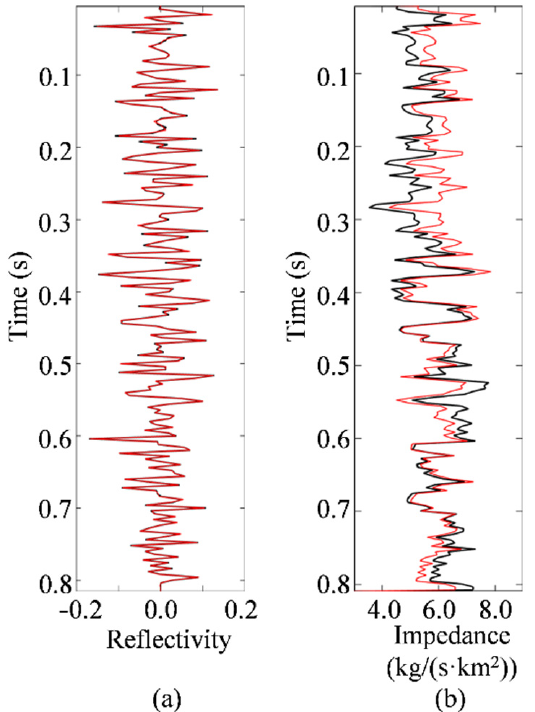
Figure 7. The inverted reflectivity series and impedances from ENRI performed on the noise-contaminated trace with SNR = 1. ( a ) Reflectivity series; ( b ) impedance.